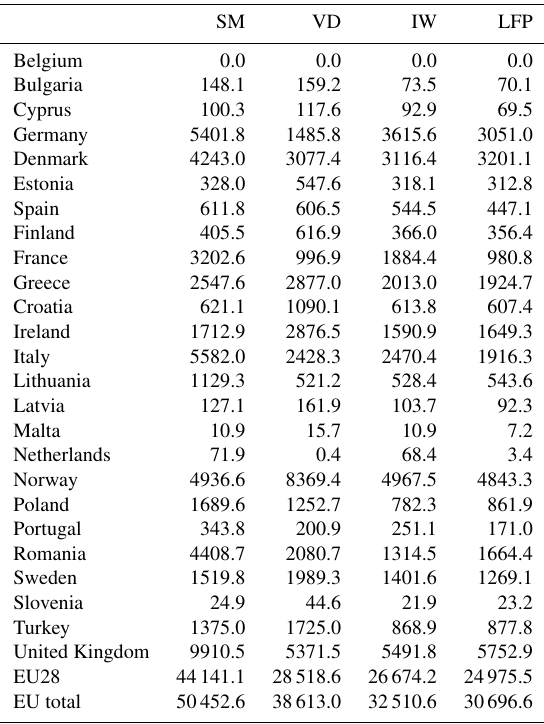
Table 1. Values of flooded area per European country for the present-day 100-year event (in km 2 ) , obtained from the four tested inundation approaches. Totals for Europe and EU28 are also pro- vided. SM VD IW LFP Belgium 0.0 0.0